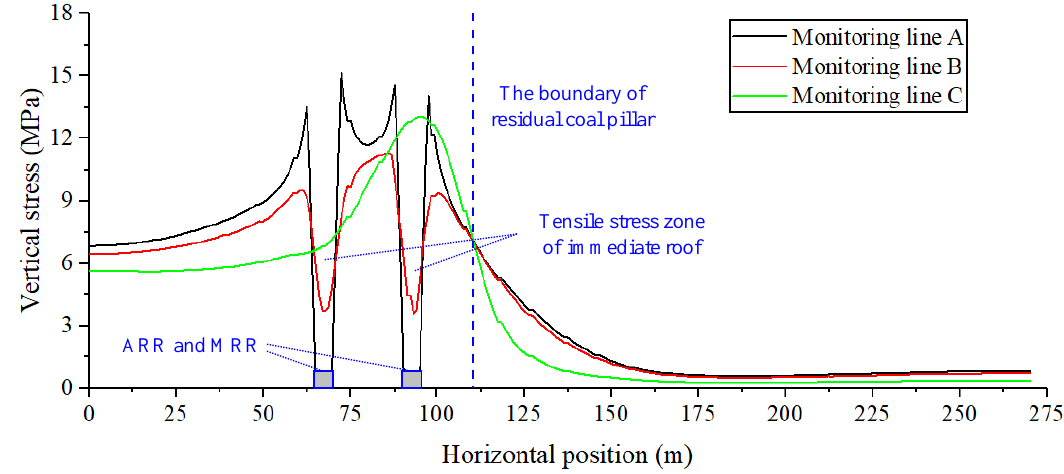
Figure 5. Stress monitoring results of measuring line.